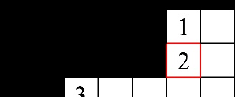
7 of 19 Figure 7. Visualization of the ZS thinning algorithm. ( a , d ) The segmentation mask of the Mask R- CNN. ( b , e ) The pest skeleton images. ( c , f ) The local details of the pest skeleton.